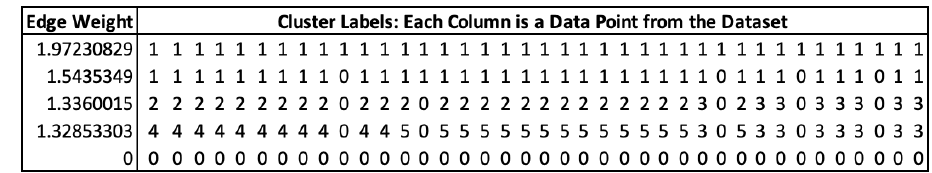
Figure 3. The minimum spanning tree of the simple dataset. An extended minimum spanning tree would contain self-edges for each point, with the weight of the self-edge being the point’s core distance value.